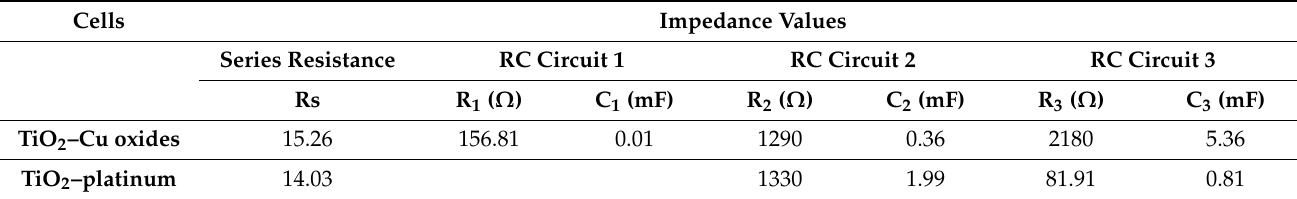
Figure 6. Equivalent circuits by curve fitting: ( a ) TiO 2 –Cu oxides cell ( b ) TiO 2 –platinum cell. Table 2. Impedance values of two cells under irradiation.